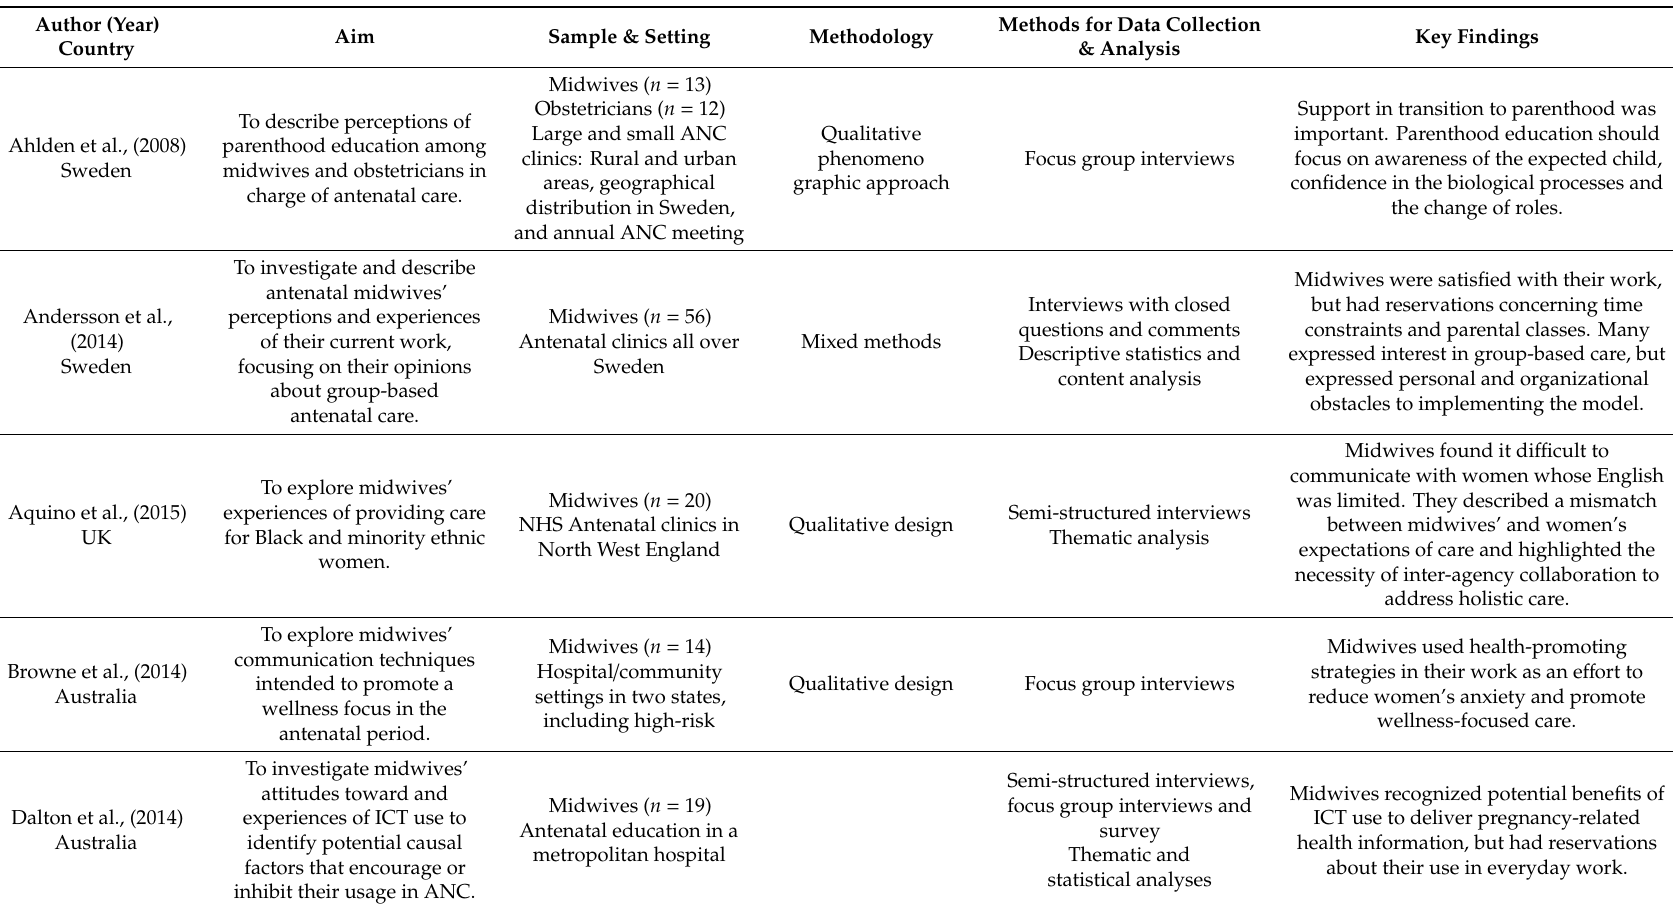
Table 3. Characteristics of included